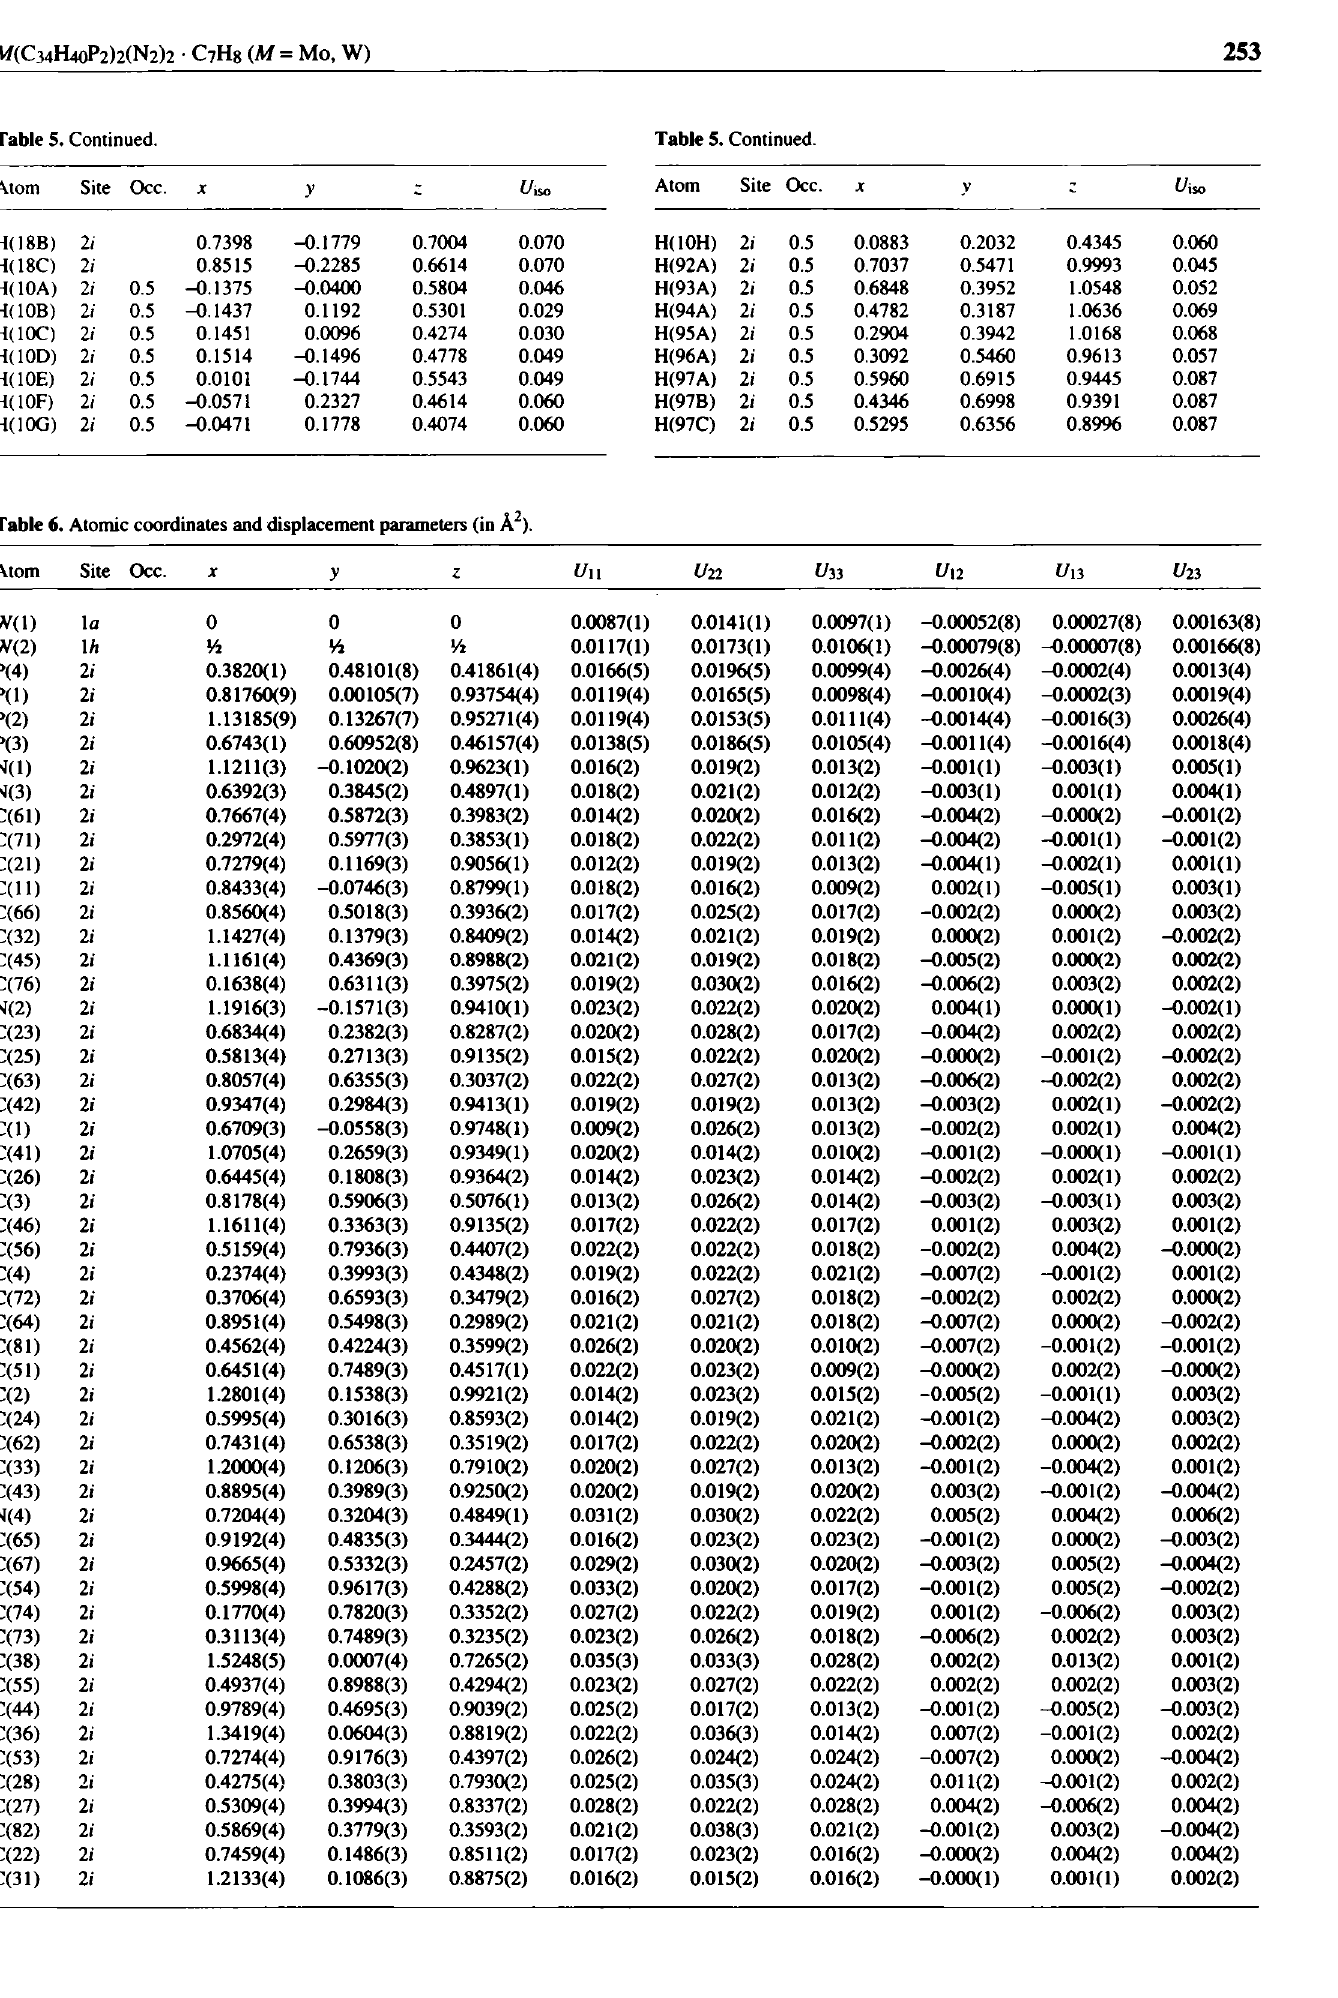
Table 6. Atomic coordinates and displacement parameters (in Ä 2